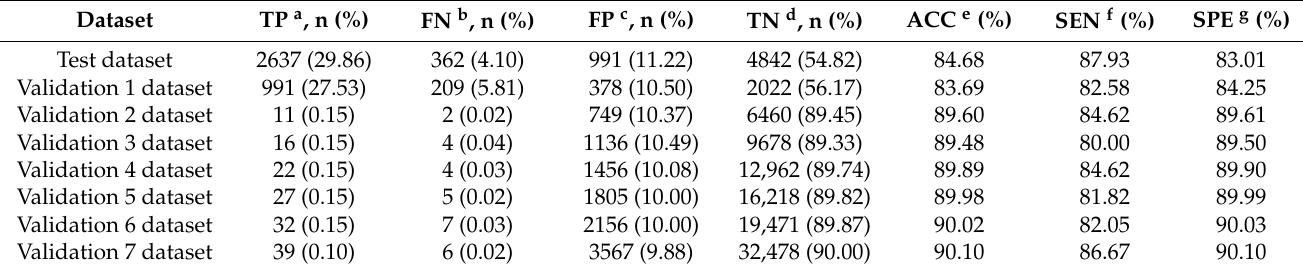
Table 3. Results of CNN model on test dataset and external validation